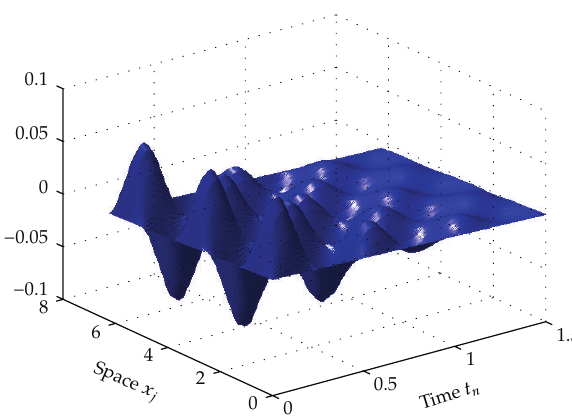
Figure 7: Total dissipation, μ (cid:8)